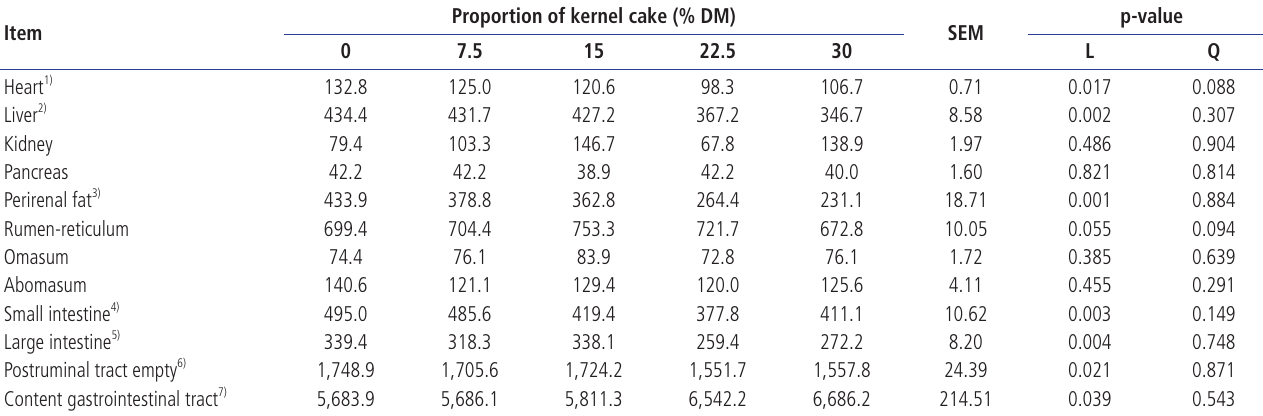
Table 4. Non-carcass components of lambs fed diet with palm kernel